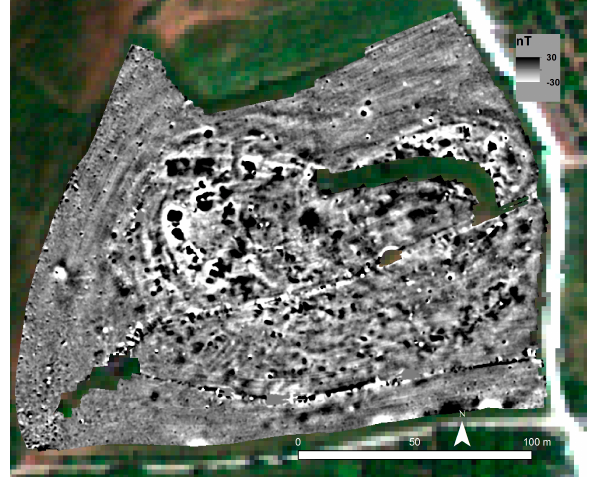
Figure 10. Geomagnetic data from Magoula Velestino-Mati. The bean shape settlement